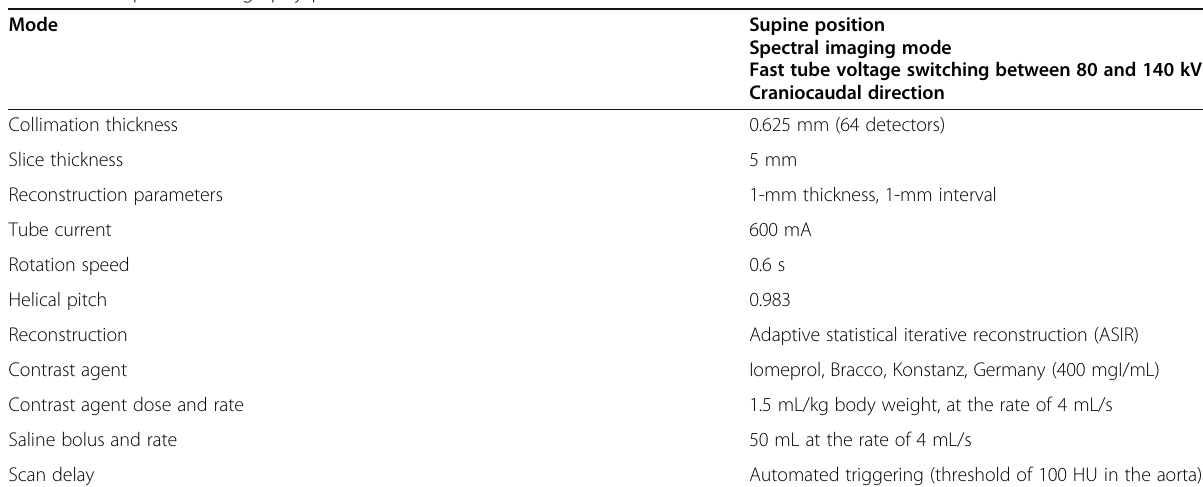
Table 1 Computed tomography protocol